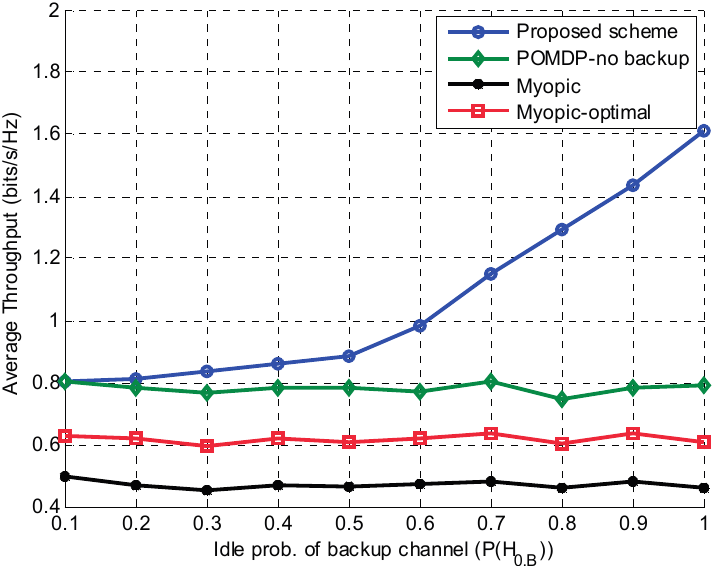
Figure 9. Effect of the backup channel idle probability on average throughput while keeping the operating channel idle probability